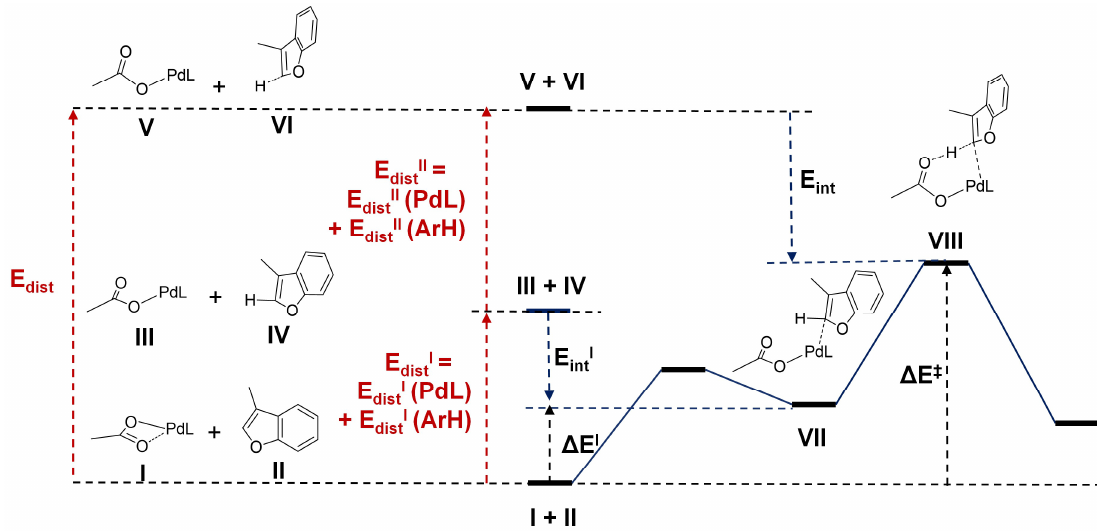
Scheme 3. Activation strain